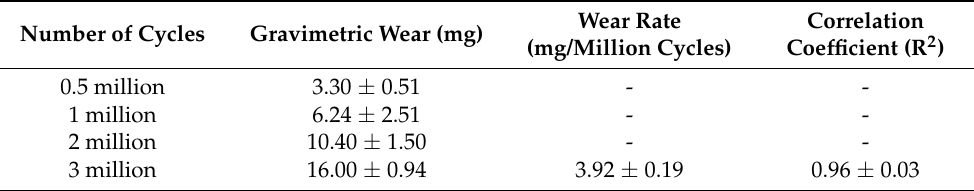
Table 1. Gravimetric wear and wear